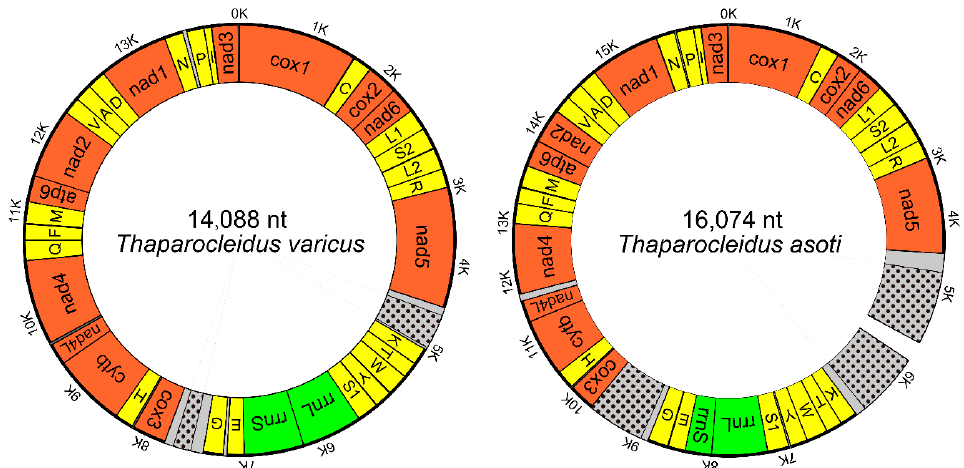
Figure 1. Maps of the circular mitochondrial genomes of Thaparocleidus asoti and Thaparocleidus varicus . Protein-coding genes are red, tRNAs are yellow, rRNAs are green, and non-coding regions (NCR) are grey. The location of the highly repetitive regions (HRR) within NCR are shown with black spot. The unsequenced gap is shown in the in the NCR of T. asoti .